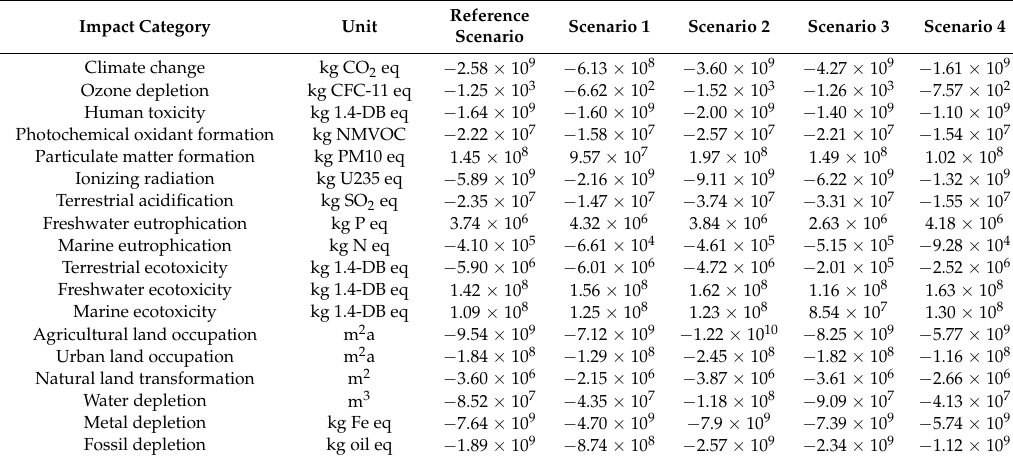
Table A9. Environmental impact for the different